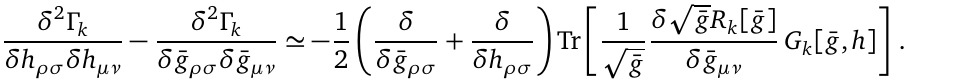
Figure 8: Fixed point values of the avatars of the Newton coupling (left panel) and the cosmological constant (right panel) as a function of N approximation (red continuous lines), in the level-one approximation (green dashed lines) and for the fluctuation system (blue dot-dashed and light blue dotted